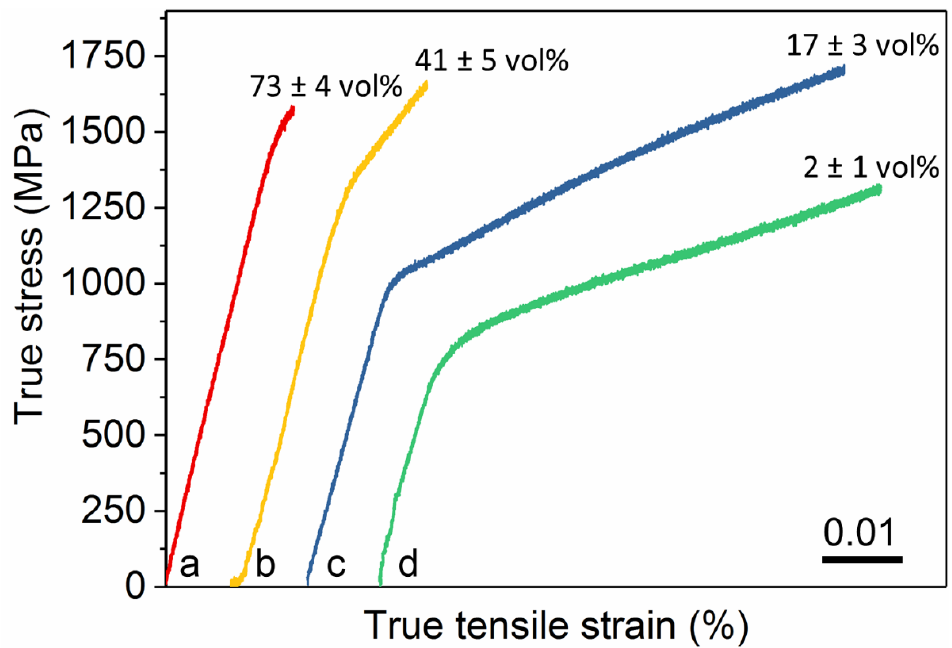
Figure 5. Room temperature tensile true stress-true strain curves of the Cu 10 Zr 7 dendrite/B2 nano- and microcomposites obtained by flash annealing the Cu 47.5 Zr 47.5 Al 5 metallic glass. (a) Annealed at 34 ± 5 MA m −2 until 1.6 s after the onset of the resistivity drop; (b) annealed at 34 ± 5 MA m −2 until the resistivity drop; (c) annealed at 44 ± 5 MA m −2 until the resistivity drop; and (d) annealed at 59 ± 5 MA m −2 until resistivity drop. The values at the end of the stress-strain curves indicate the volume fraction of the Cu 10 Zr 7 dendrites. (Stress-strain curve “d” is adopted from [20]).